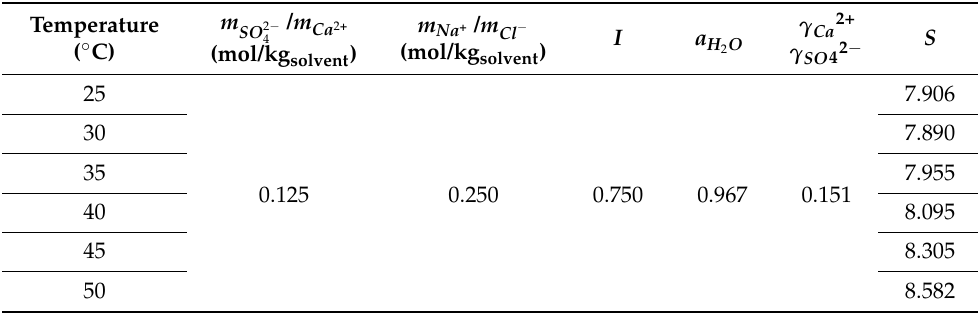
Table 7. Supersaturation, molality, ionic strength and activity of water for various temperature and constant concentration of 0.25 (mol/dm3).